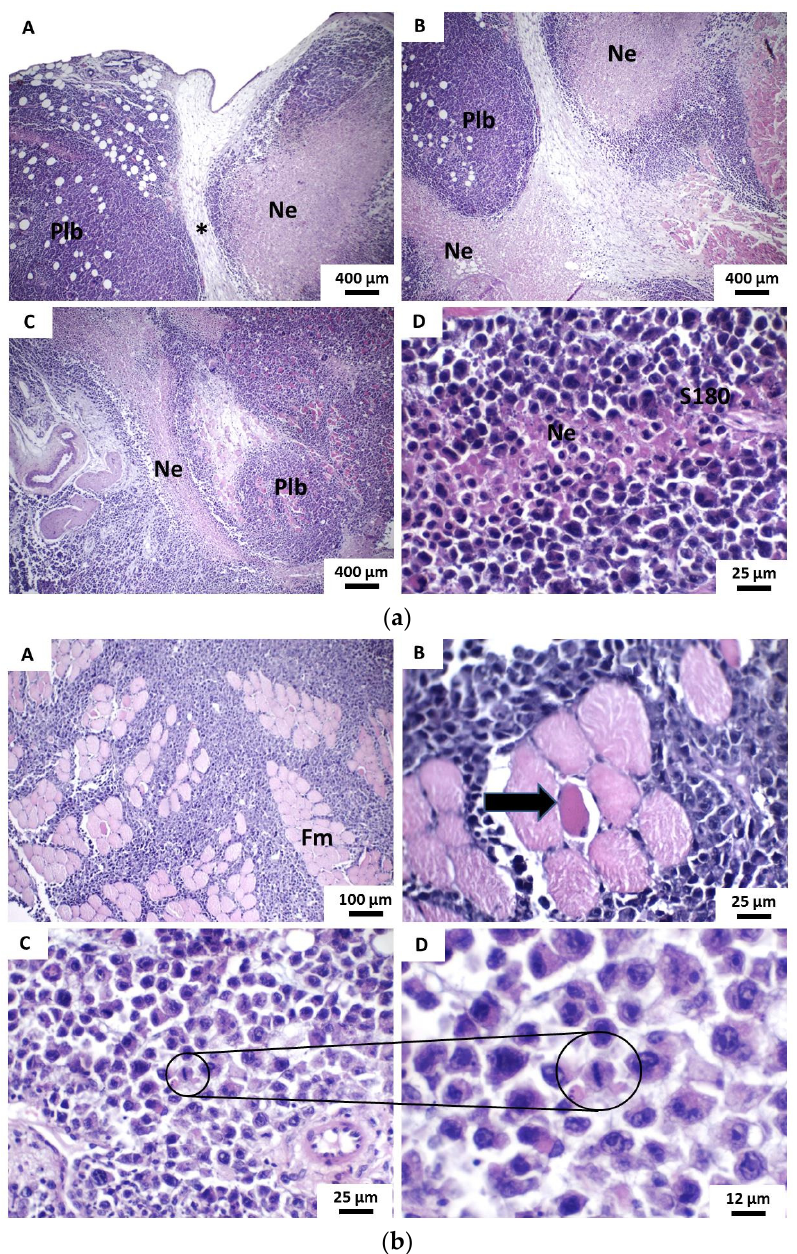
Figure 7. Photomicrographs of histological sections stained in HE show the main histopathological features of tumors developed in the β -CD:POH 50 mg/Kg group from the implantation of S180 cells. ( a ) (A–C) Tumor cells organized in a pseudolobular pattern (sometimes septated by fibrous connective tissue and sometimes by irregular bands of necrotic tissue) (40×). (D) Small necrotic tissue trabic amid tumor sheet cells (400 ×). Caption: Coagulative necrosis; Plb—pseudolobules; S180—viable sarcoma 180 tumor cells and ( b )(A) Tumor cells infiltrate and dissociate solid blocks of muscle fibers (Fm) (100×). (B) Apoptosis of muscle cell (black arrow) in response to tumor infiltration (400×). (C) Atypical tumor cells showing low cohesivity and mitotic activity (400×). (D) Detail mitotic figure of tumor cell in metaphasis (800×).